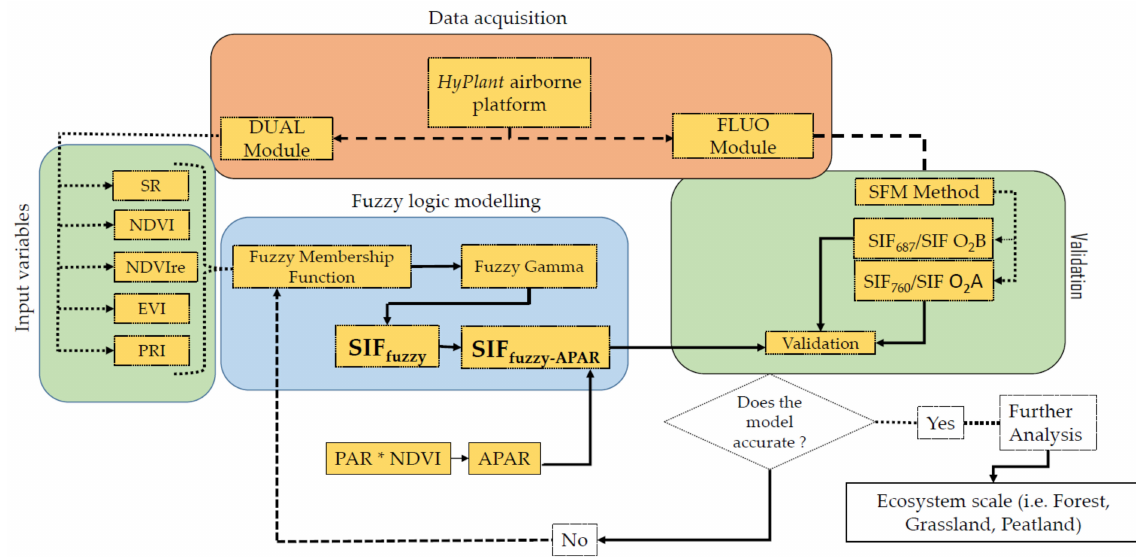
Figure 3. Scheme of the research methodology and different steps of data processing from HyPlant data acquisition to model building and validation of the